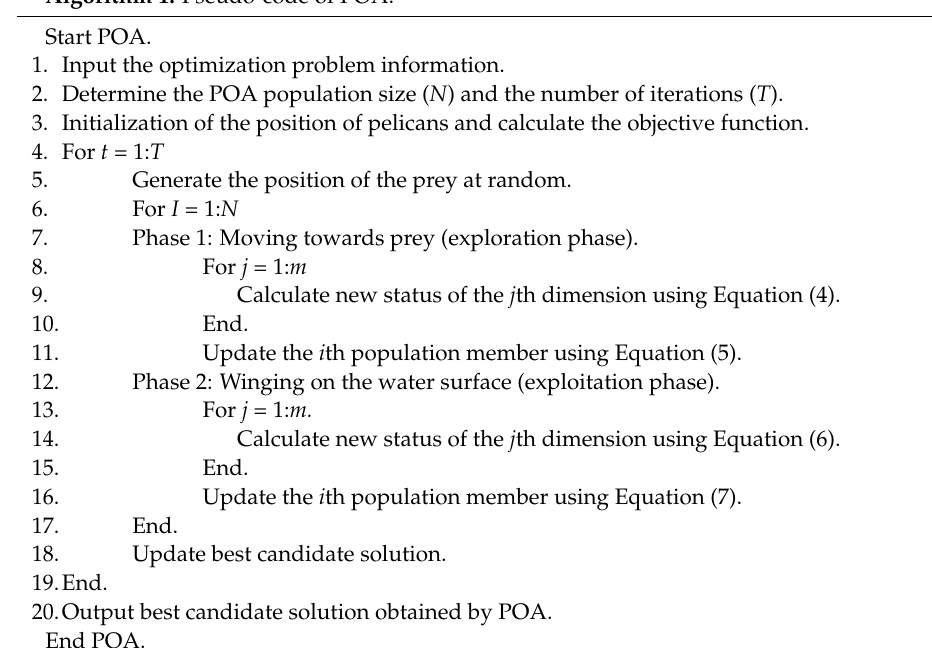
Algorithm 1. Pseudo-code of